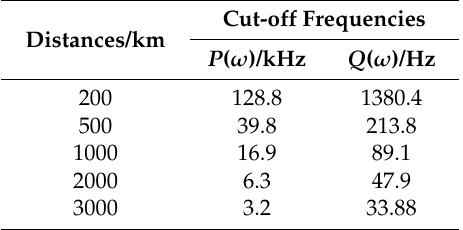
Table 1. Cut-off frequencies of modulus TWs with different distances.